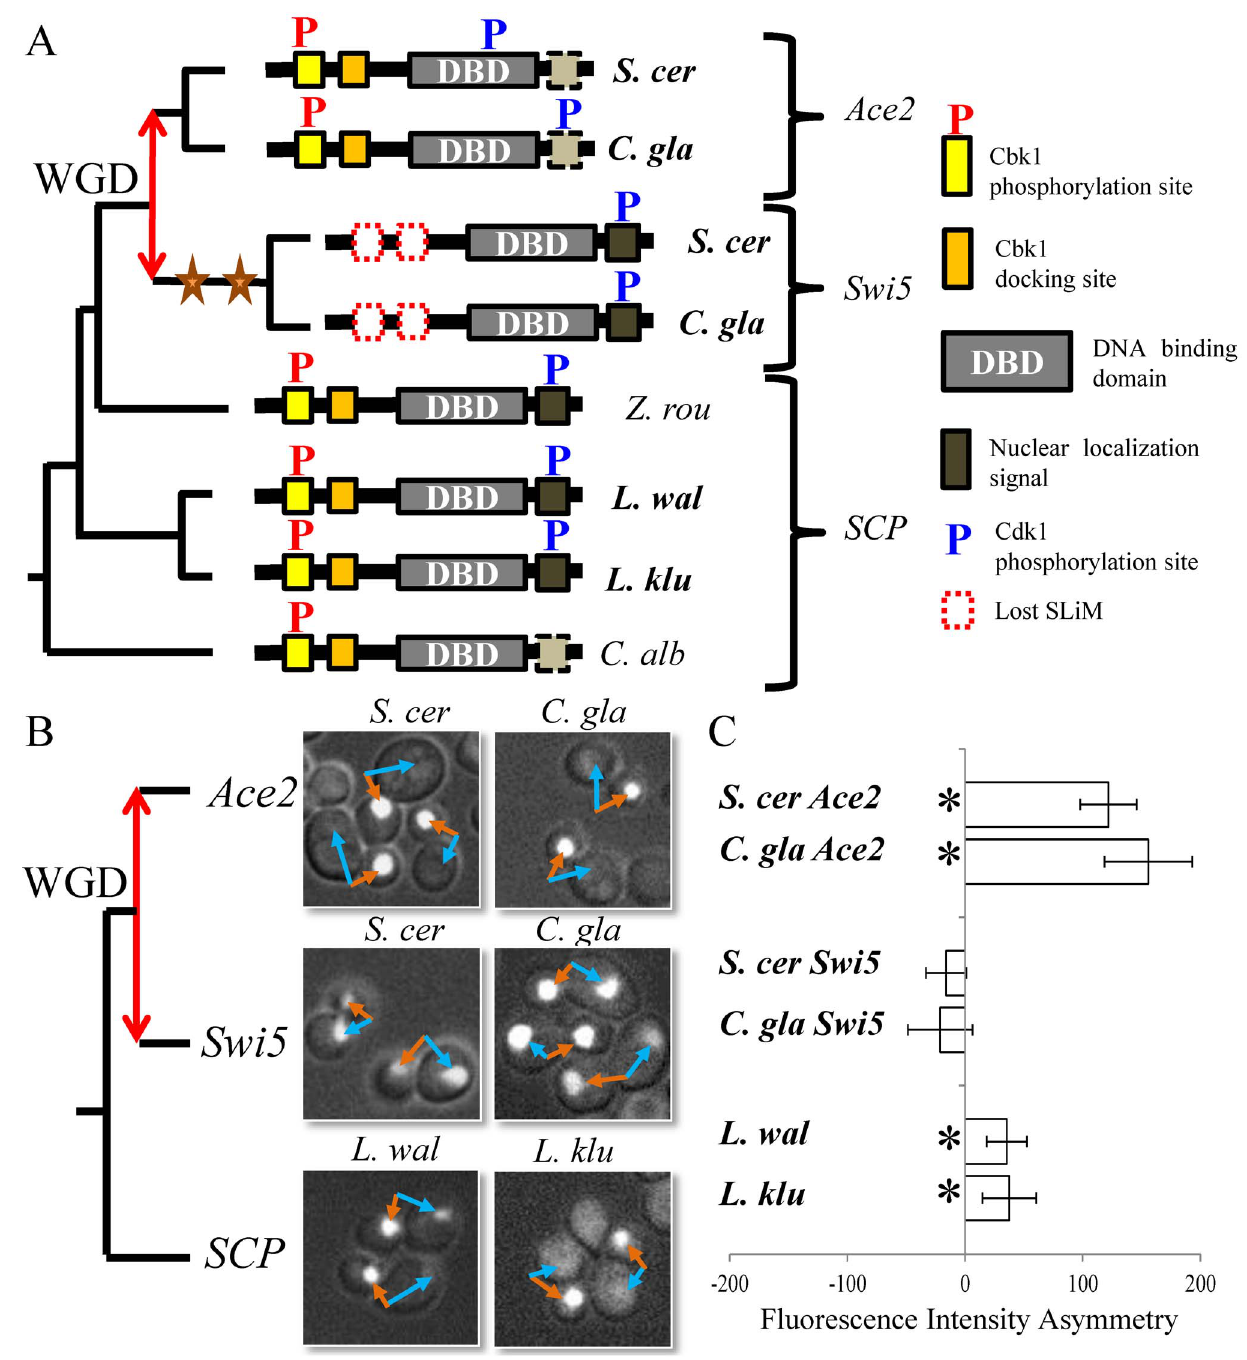
Fig. 5. Posttranslational change in regulation after gene duplication in Swi5 and Ace2. A) Schematic of the gene tree relating the Ace2/ Swi5 paralog pair with diagram of protein features found in proteins from different yeast species. Bolded species name indicate cloned genes assayed for localization in S. cerevisiae . The nuclear localization signal characterized in Swi5 is putatively altered and may not be functionally homologous in Candida and Ace2, but this difference was not predicted in our analysis (see Discussion and S3 Figure). B) Green-fluorescent protein tagged genes cloned from the labeled species were assayed for their localization in unsynchronized S. cerevisiae cells. Two representatives of each pre-/post-WGD genes were assayed. Orange and blue arrows indicate representative bud and mother nucleus pairs. C) The fluorescence intensity of the nucleus in cells expressing the labeled proteins was quantified, and mean difference of the intensity (bud-mother) is used as the measure of asymmetry (unfilled bars). Error bars show 95% confidence interval of the mean. Stars indicate 5% statistical significance. Red double arrow illustrates the duplication event. Scer: S. cerevisiae , Cgla: C. glabrata , Zrou: Z. rouxii , Lwal: L. waltii , Lklu: L. kluyveri , Calb: C. albicans .